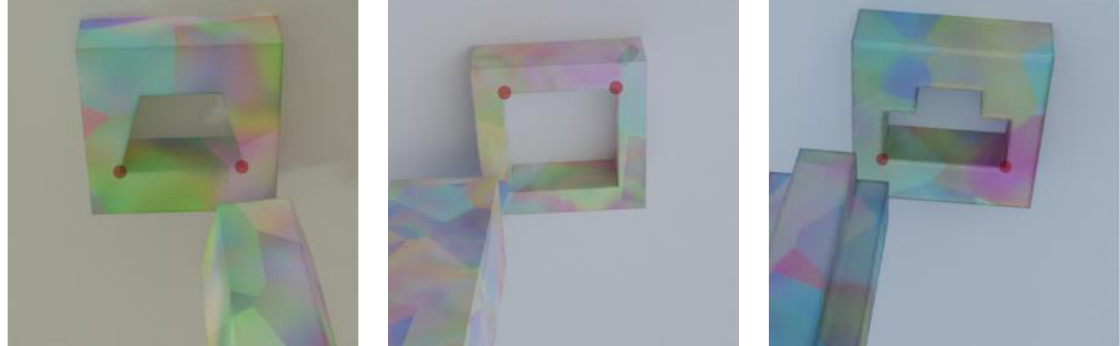
Figure 9. Workpiece landmarks for different holes.